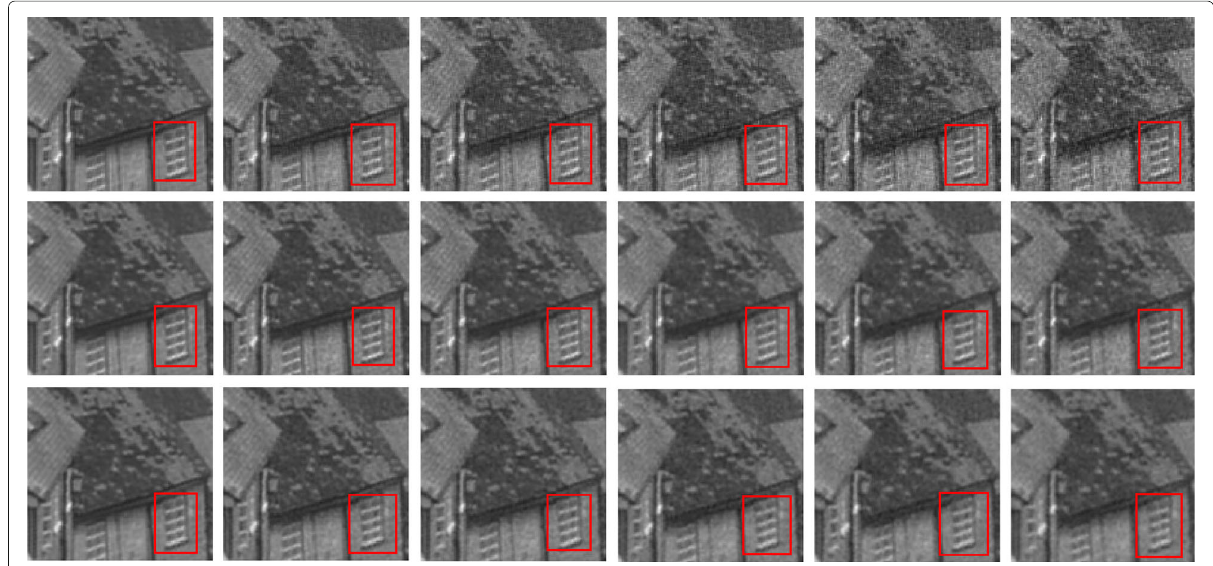
Fig. 3 The final reconstructed HR images using different update strategies. Top row: using multiplicative update strategy. Middle row: using manual step size update strategy. Bottom row: adaptive step size update strategy. The noise variances of corresponding LR images are 0, 10, 20, 30, 40, and 50 respectively from left to